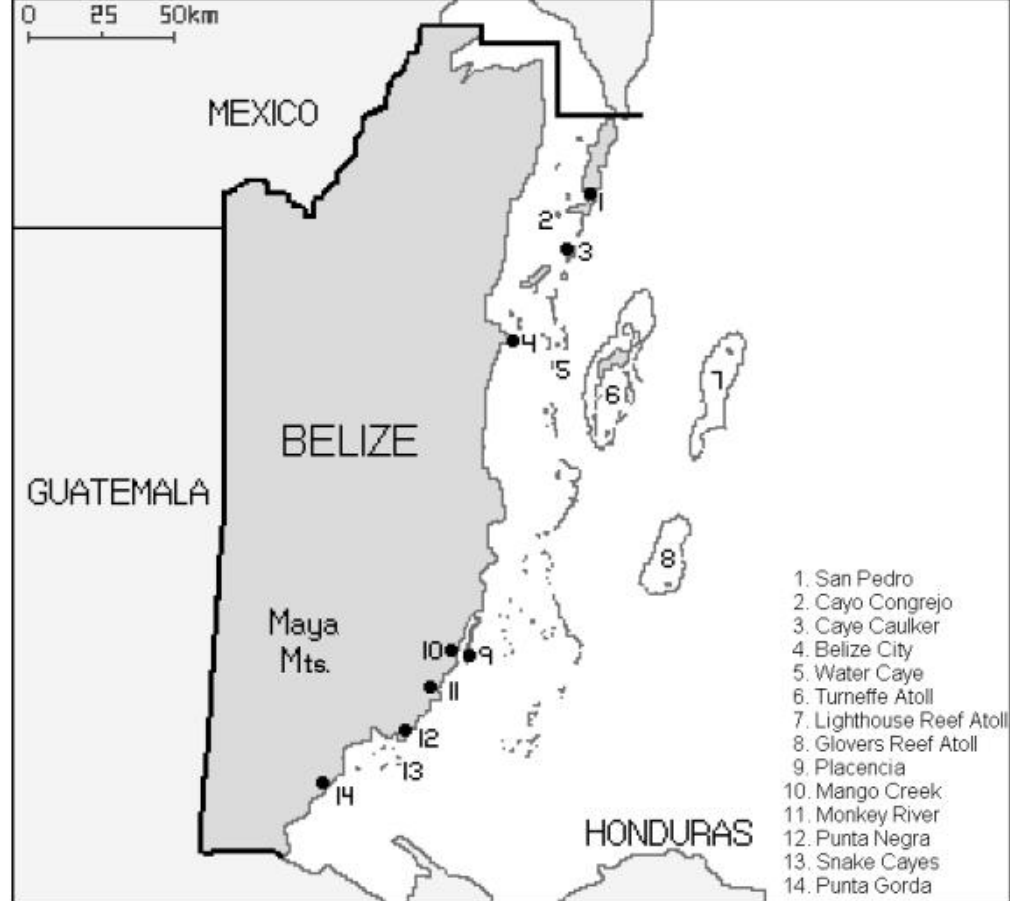
Fig. 1. Belize, Central America. The coastline with its offshore barrier reef and atolls, and the coastal towns and fishing villages referred to in the